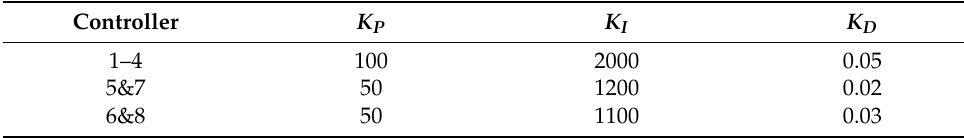
Table 3. Controller parameters of experimental system.